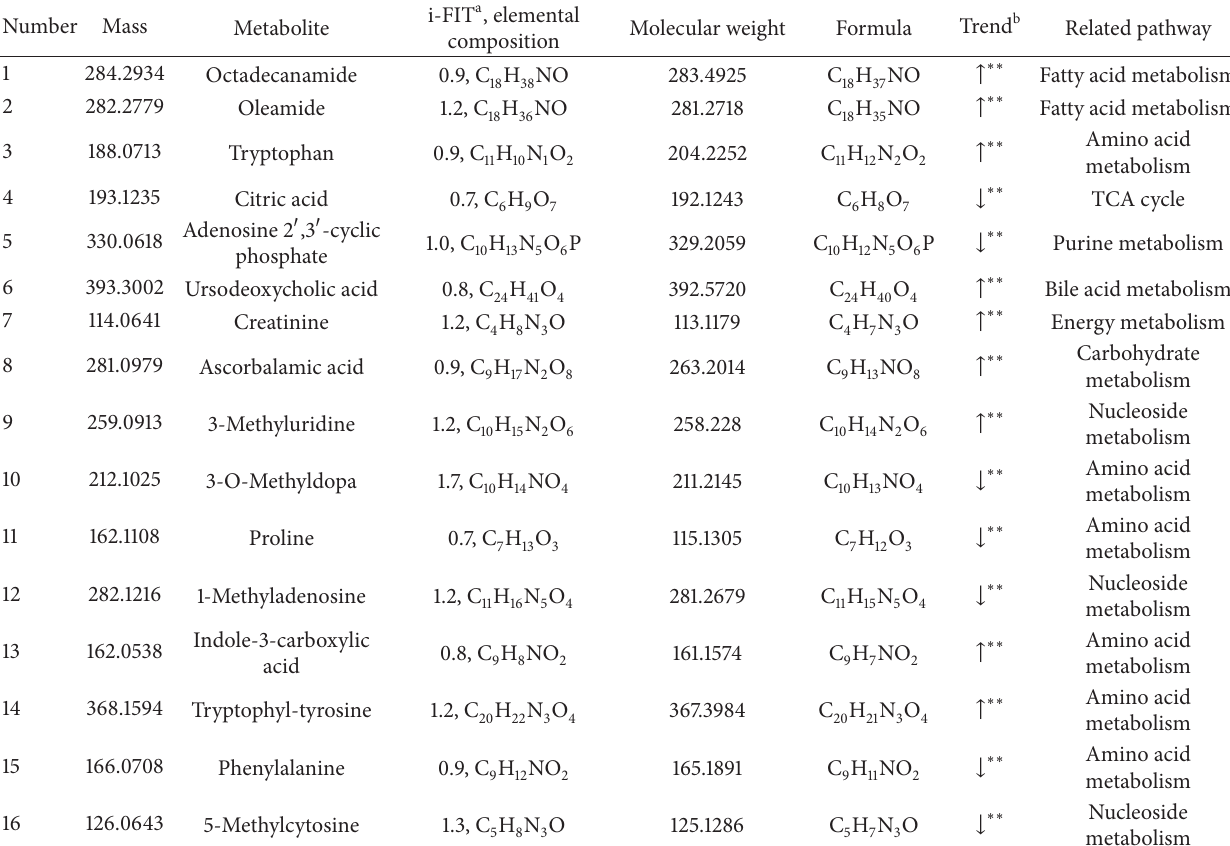
Table 1: 13 biomarkers of hyperlipidemia detected by UPLC Q-TOF/MS in negative ion mode in the 4th